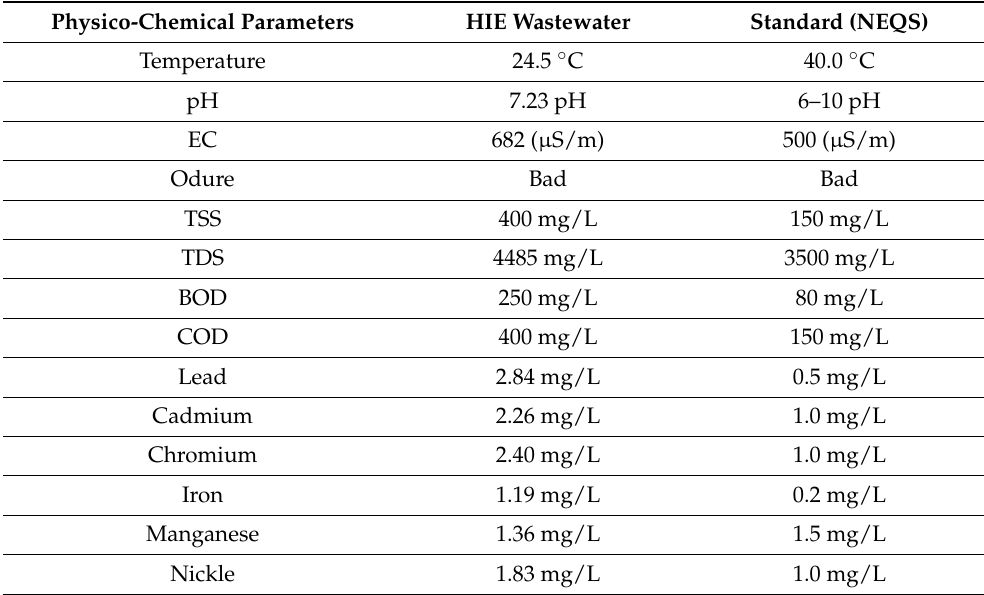
Table 2. The physico-chemical parameters of the Hayatabad industrial estate (HIE) were analyzed to evaluate the pollution load and HMs content in water and compare it with permissible limit of National Environment Quality Standard (NEQS) for industrial effluents.